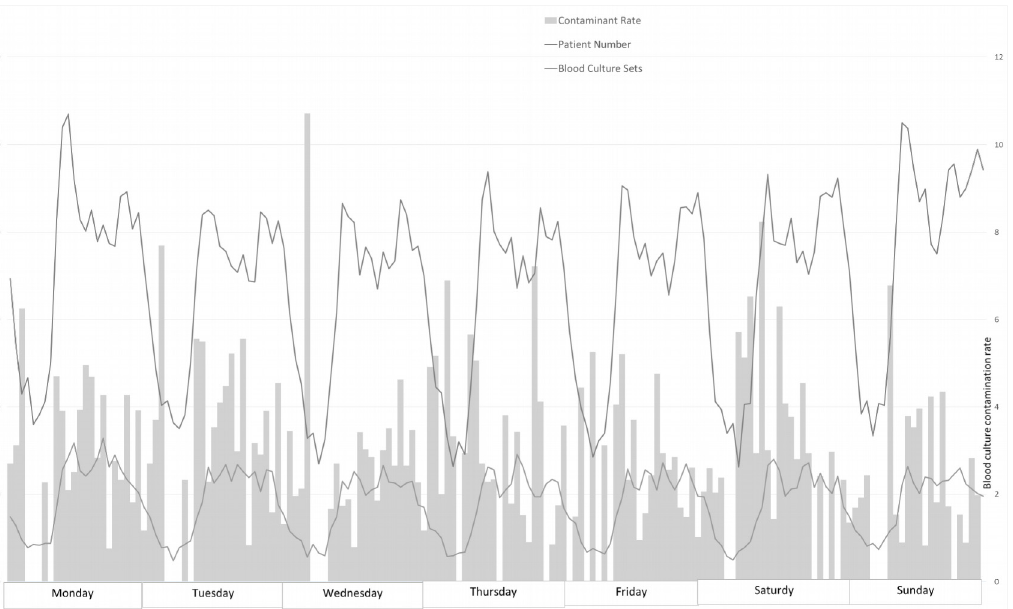
Fig 1. Diurnal variability in patient visits, blood culture activity, and contaminant culture rate. (Bottom) Hourly variation in ED census (the number of patients in the ED during any hour) over the week, colum,right, contamination rate.